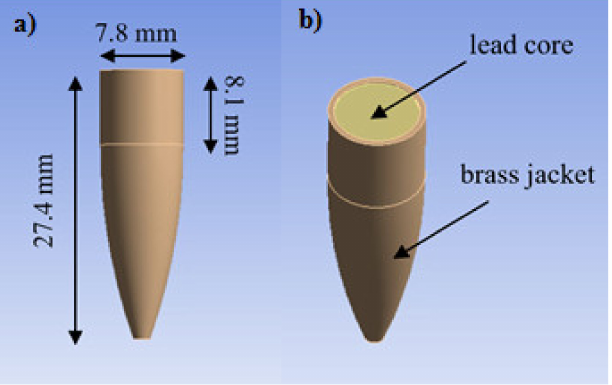
Figure 2. ( a ) The geometry of the 7.62 × 51 mm 2 projectile and ( b ) the materials used in the jacket and core of the projectile.